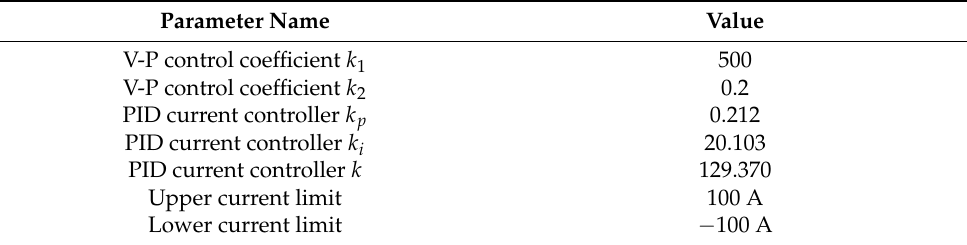
Table 2. Microgrid control